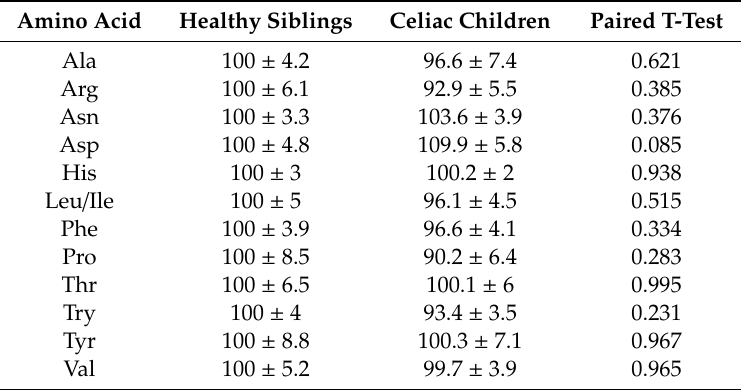
Table 4. Plasma amino acids content in celiac patients and healthy siblings.